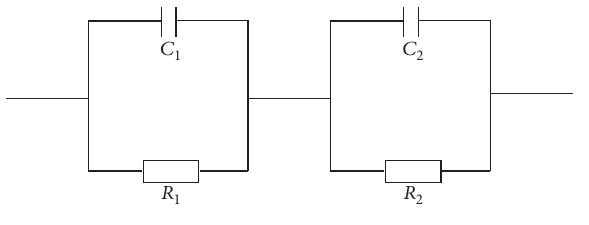
Figure 2: Converted equivalent circuit.